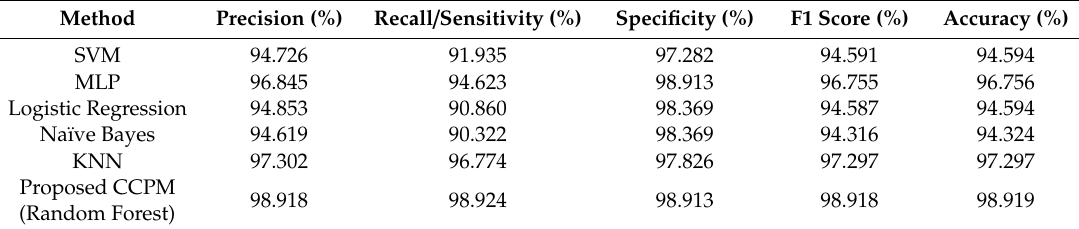
Table 9. Performance evaluation results based on iForest and SMOTETomek for Biopsy.